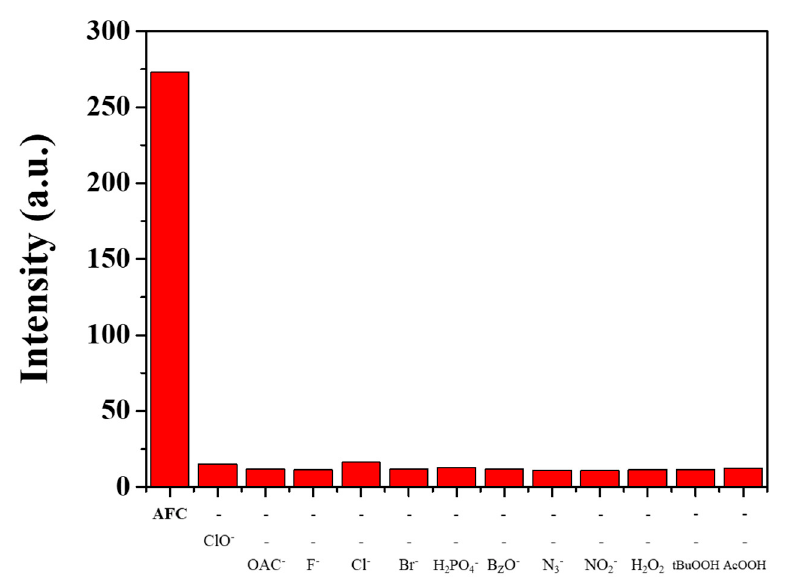
Figure 5. Competitive test (455 nm) of AFC (1 × 10 − 5 M) to ClO − (290 equivalents) in the presence of other anions (290 equivalents).